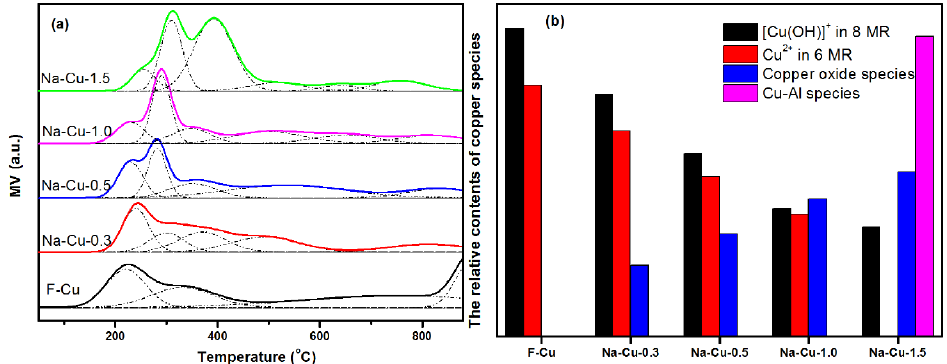
Figure 6. H 2 -TPR results ( a ) and qualitative results ( b ) of fresh and Na-impregnated catalysts.